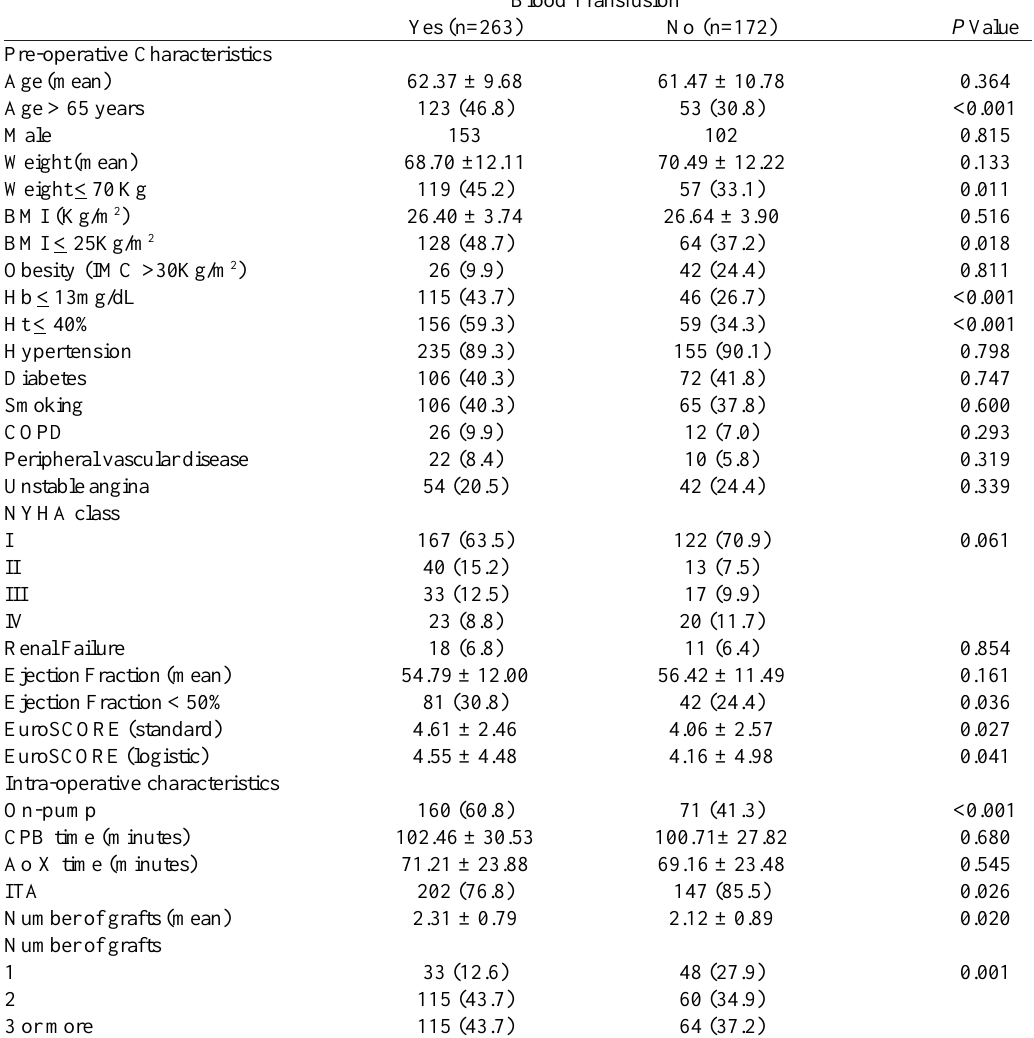
Table 1. Baseline Patients’ Characteristics Stratified by Blood Transfusion